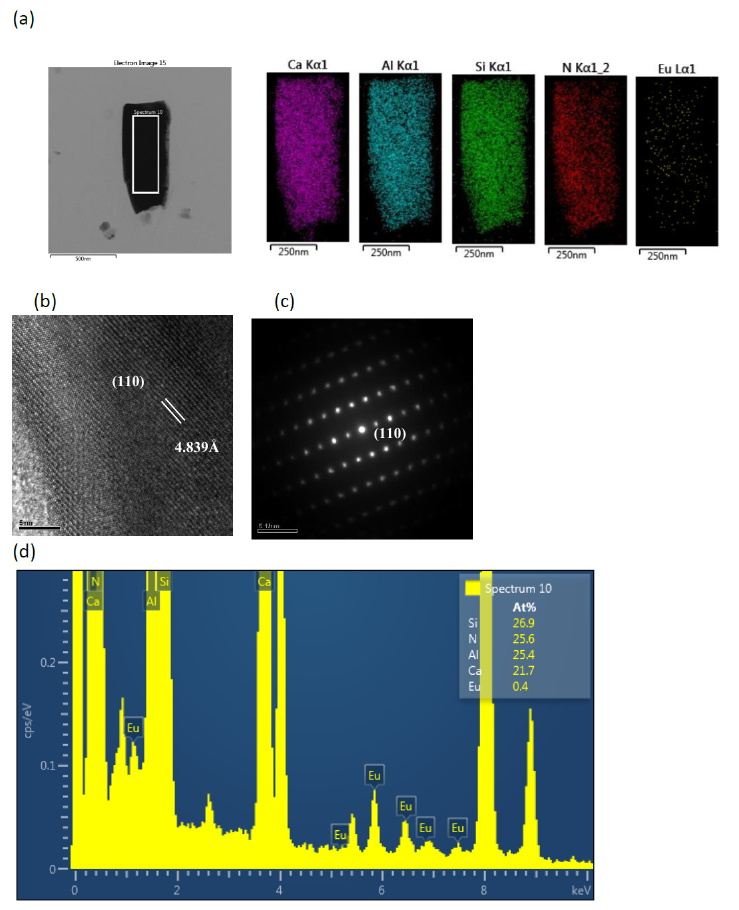
Figure 3. ( a ) TEM image and corresponding element mapping of Ca, Al, Si, N, Eu; ( b ) HRTEM image; ( c ) SAED pattern; and ( d ) element analysis of a rod-like particle (showing it to be CaAlSiN 3 :Eu 2+ ) in a product synthesized with Ca:Al:Si:Si 3 N 4 :Eu 2 O 3 :NaN 3 :NH 4 Cl = 1.0:1.0:0.25:0.25:0.02:3.5:0.6.